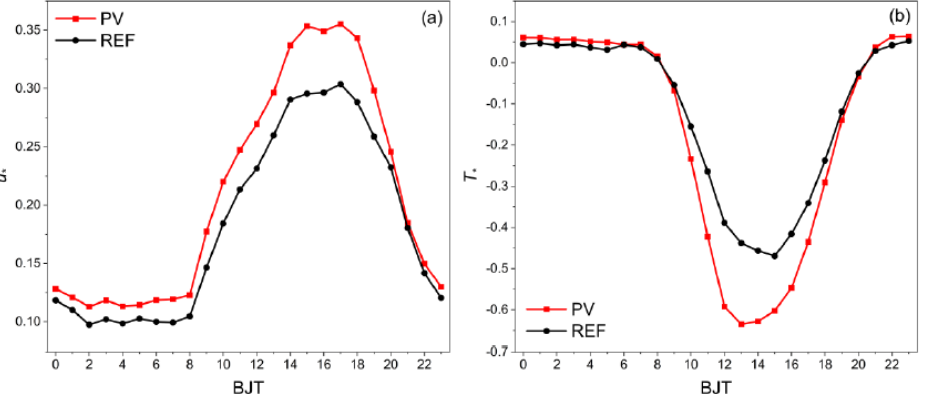
Figure 3. Diurnal variation of the scaling parameter of velocity u ∗ ( a ) and temperature T ∗ ( b ) in the PV plant (red line) and the reference site (black line), BJT is to Beijing time.